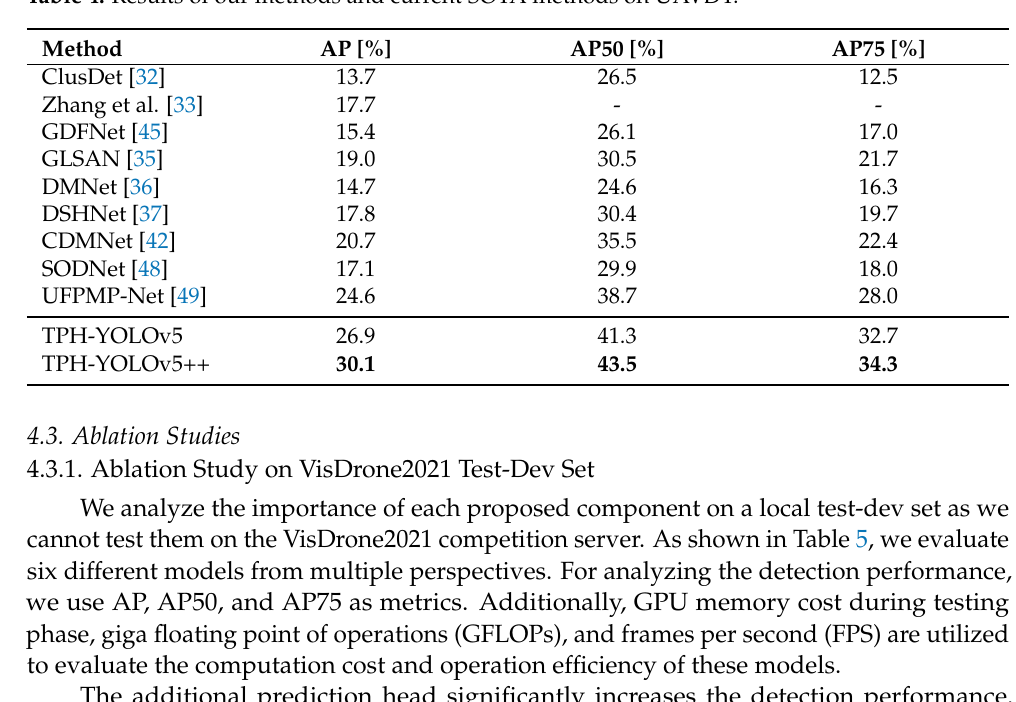
Table 4. Results of our methods and current SOTA methods on